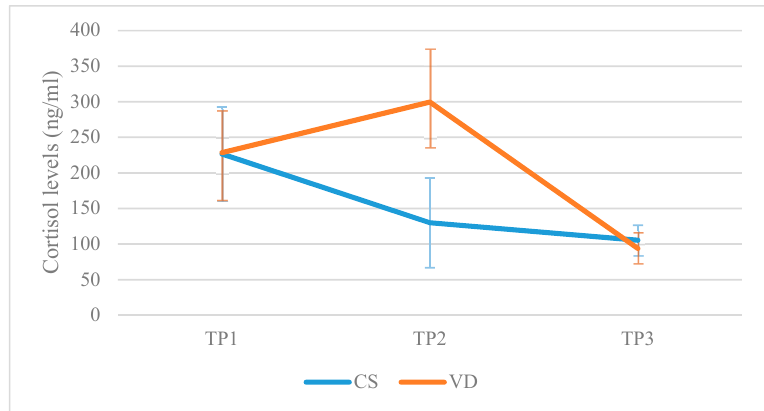
5 of 15 Table 1. Mean and standard deviation (Mean ± SD) of patients’ general characteristics. Patients’ Characteristics Table 2. Mean maternal serum hormonal levels reported on each of the three separate time-points (TP1: Prior to labor; TP2: 120 min following placenta delivery; TP3: 48 h following placenta delivery). Data are presented in the Mean ± SD format. Time Point 1 Time Point 2 Time Point 3 Vaginal Delivery Group Caesarean Section Group Caesarean Section Group